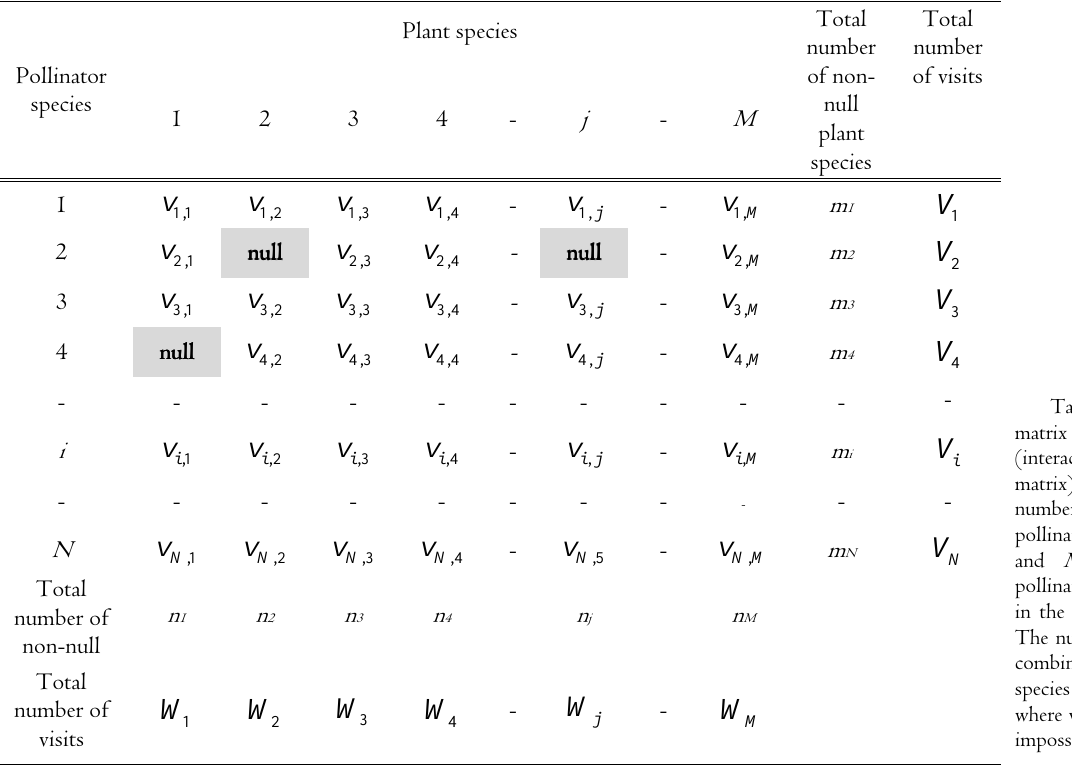
Table 1. The data matrix of visitation data (interaction frequency matrix),with the